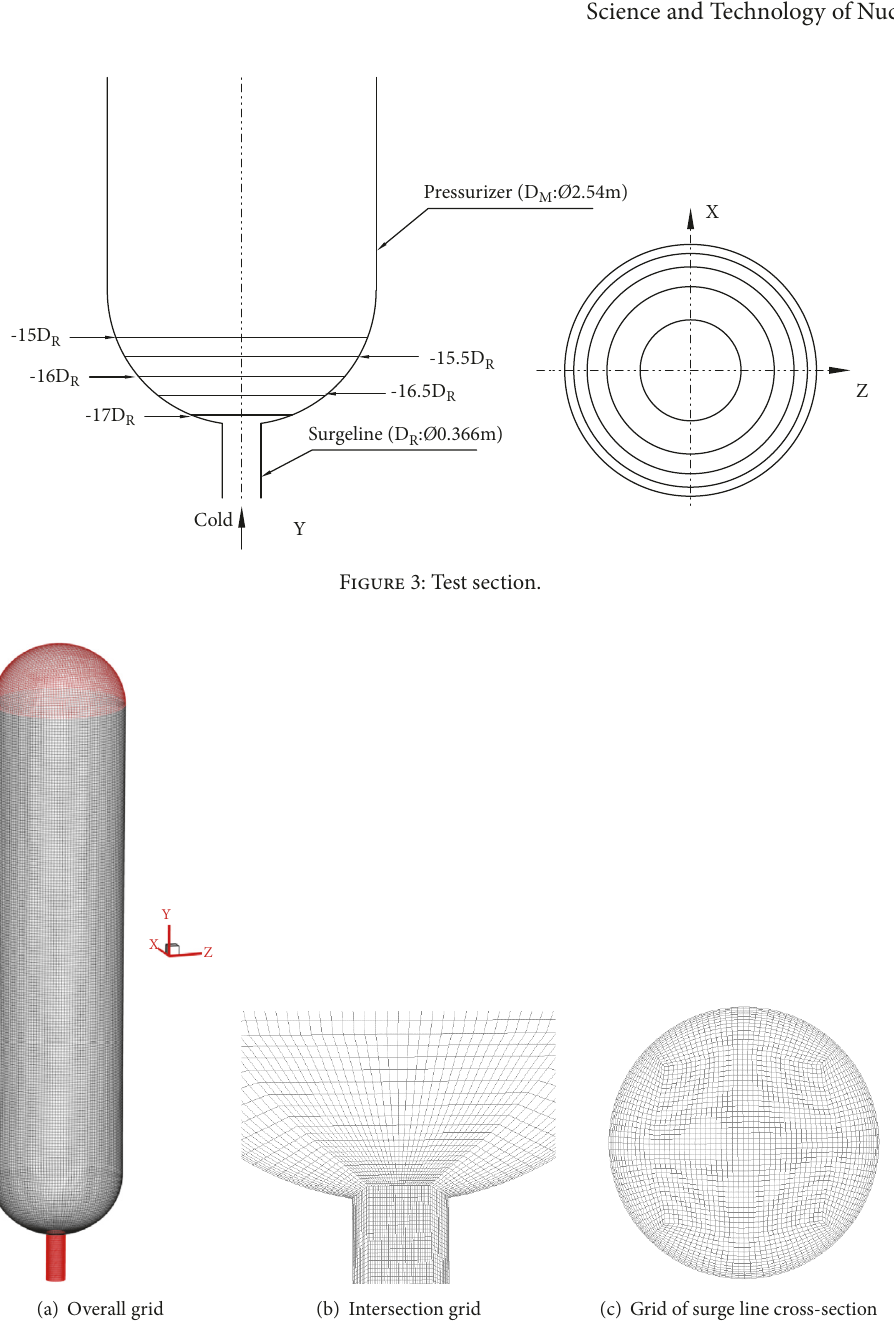
Figure 4: Grid of fluid flow